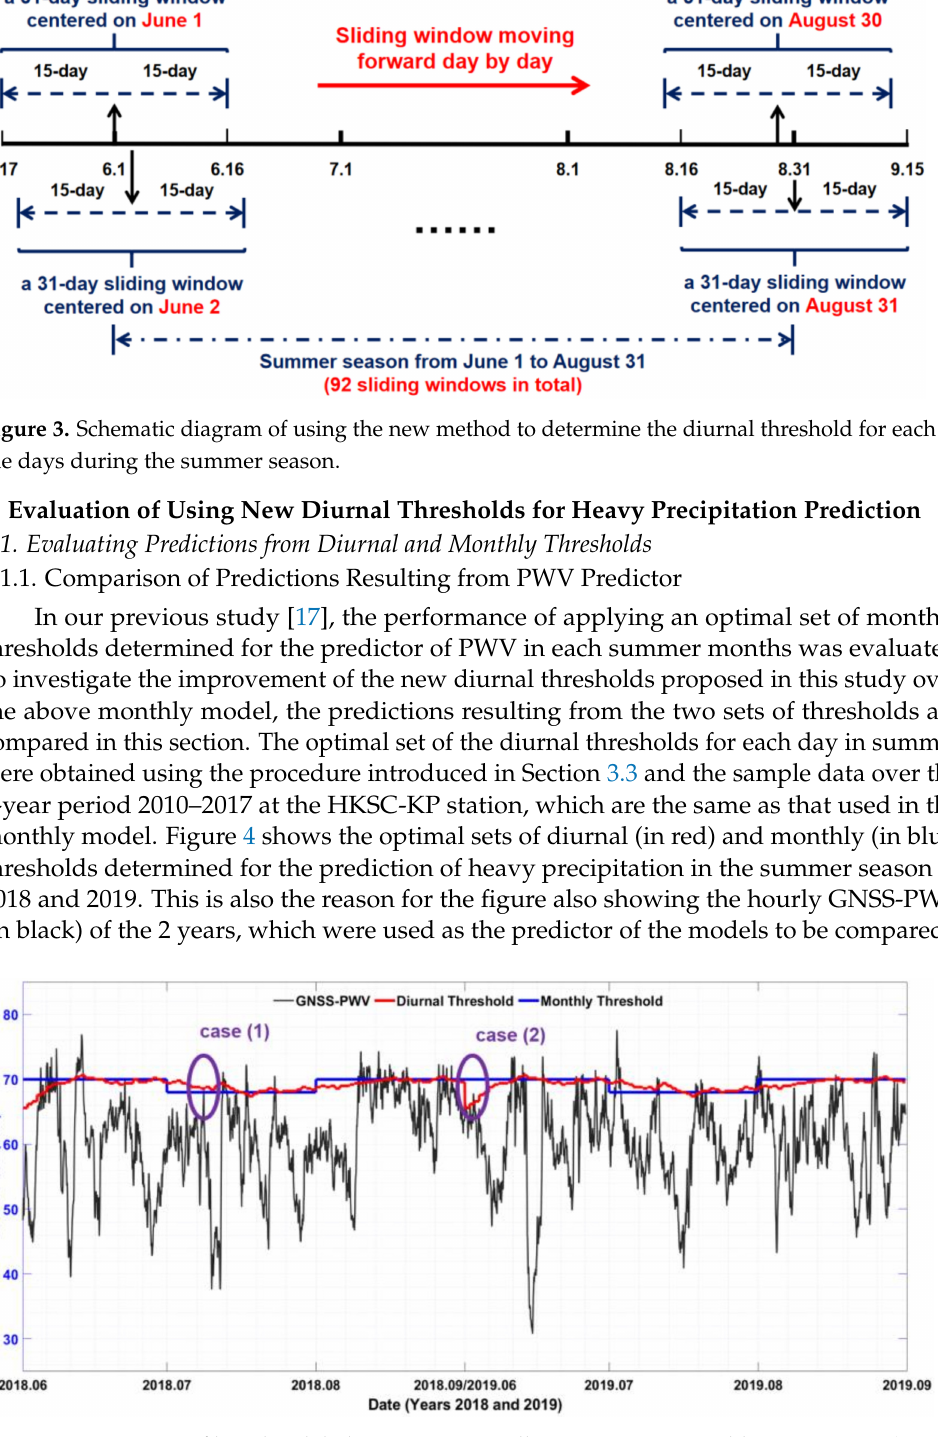
Figure 4. Timeseries of hourly Global Navigation Satellite System-precipitable water vapor (GNSS- PWV) (black), and diurnal (red) and monthly (blue) precipitation thresholds determined for the prediction for the summer season in 2018 and